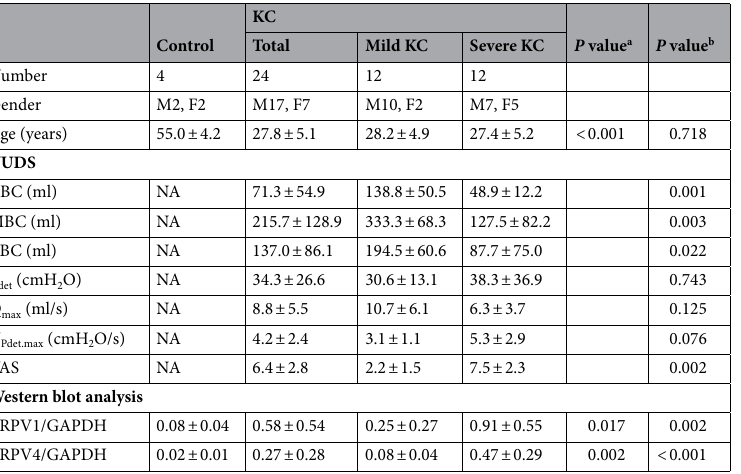
Table 1. Clinical characteristics and Western blot analysis data of KC patients and control subjects. The Western blot analysis was normalized against GAPDH. CBC cystometric bladder capacity, MBC maximal bladder capacity, ΔBC the difference between MBC and CBC, P det detrusor pressure, V Pdet.max velocity to reach maximal P det (cm H 2 O/s, defined as the slope of pressure to time from the start of detrusor contraction to reach P det.max ), Q max maximum flow rate, VAS visual analog score. a P values between all KC patients and controls, b P values between mild KC and severe KC